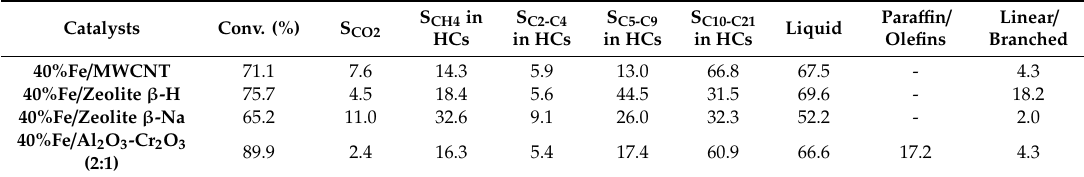
Table 1. The results of the activity measurements expressed as CO conversion and selectivity towards all products of the Fischer-Tropsch (F-T) process performed at 280 ◦ C under elevated pressure (3 MPa) from a mixture of H 2 and CO (molar ratio